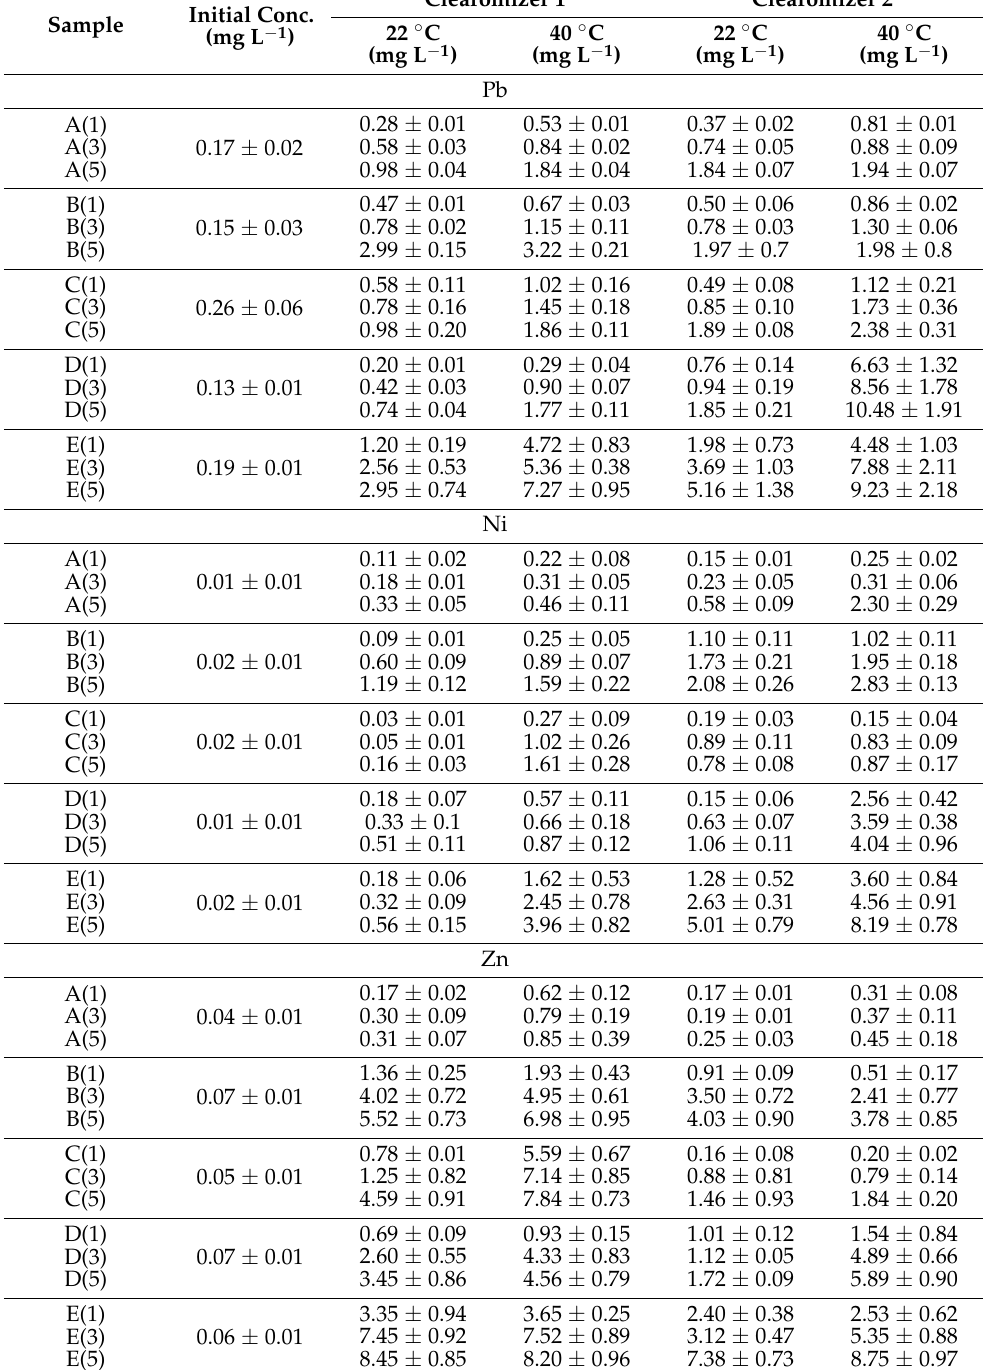
Table 4. Heavy metals (Pb, Ni, Zn) concentrations in EC liquids under different conditions.